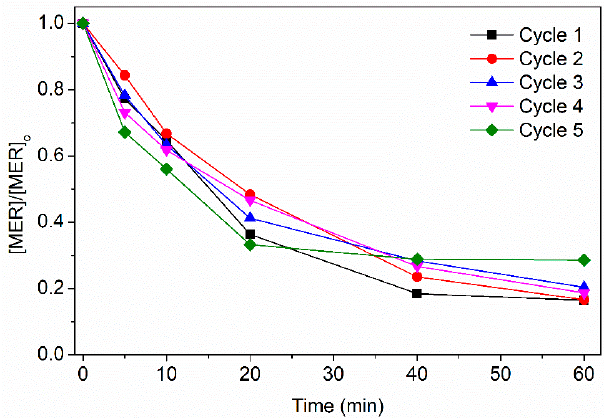
Figure4. PhotocatalyticdegradationkineticsofMERobtainedforthe5cyclesofreuseoftheTiO 2 / fiberglass Figure 4. Photocatalytic degradation kinetics of MER obtained for the 5 cycles of reuse of the substrates ([MER] o = 100 mg / L, pH = 5.7). TiO 2 /fiberglass substrates ([MER] o = 100 mg/L, pH = 5.7).